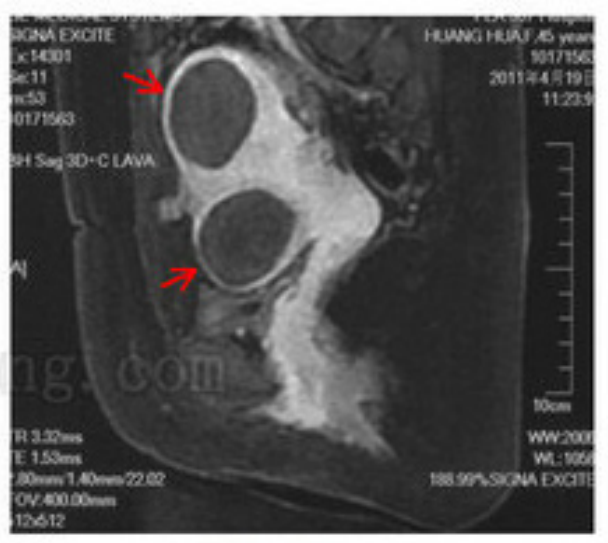
Figure 4. Status of fibroid before UAE